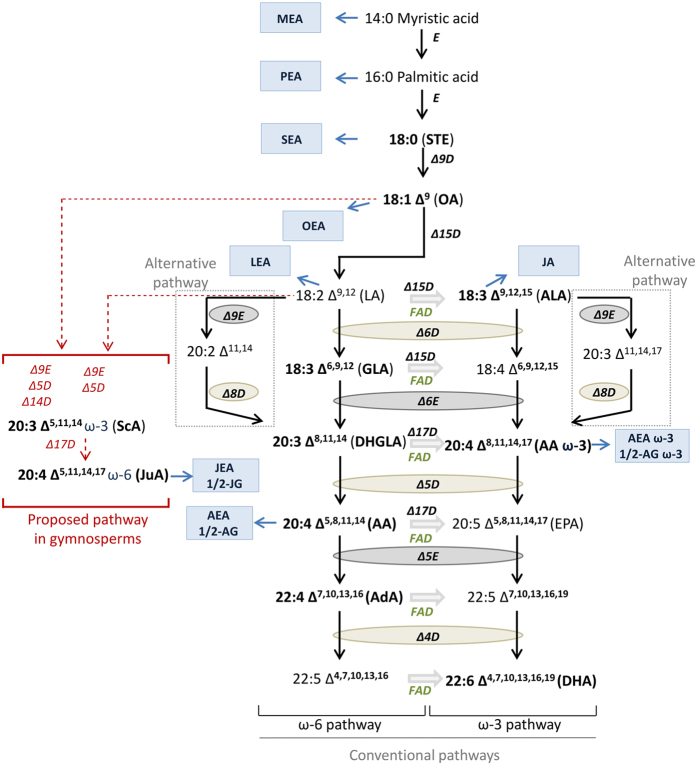
Conventional and alternative biosynthetic pathways for the production of PUFAs in eukaryotes.In green, the switch between ω-3 and ω-6 pathways characteristic of plants and nematodes through the action of ω-3 desaturases (FAD) is highlighted. Desaturases (D) and elongases (E) are shown together with the position at which the enzymatic reaction takes place. Red arrows highlight a proposed pathway for the biosynthesis of ScA and JuA in gymnosperms. For simplicity, the FA substrates here presented do not differentiate between acyl-lipid, acyl-ACP or acyl-CoA that occur either free or bounded to glycolipids. FAs investigated (bold) as well as the bioactive metabolites (blue squares pointed by blue arrows) that were investigated are shown.